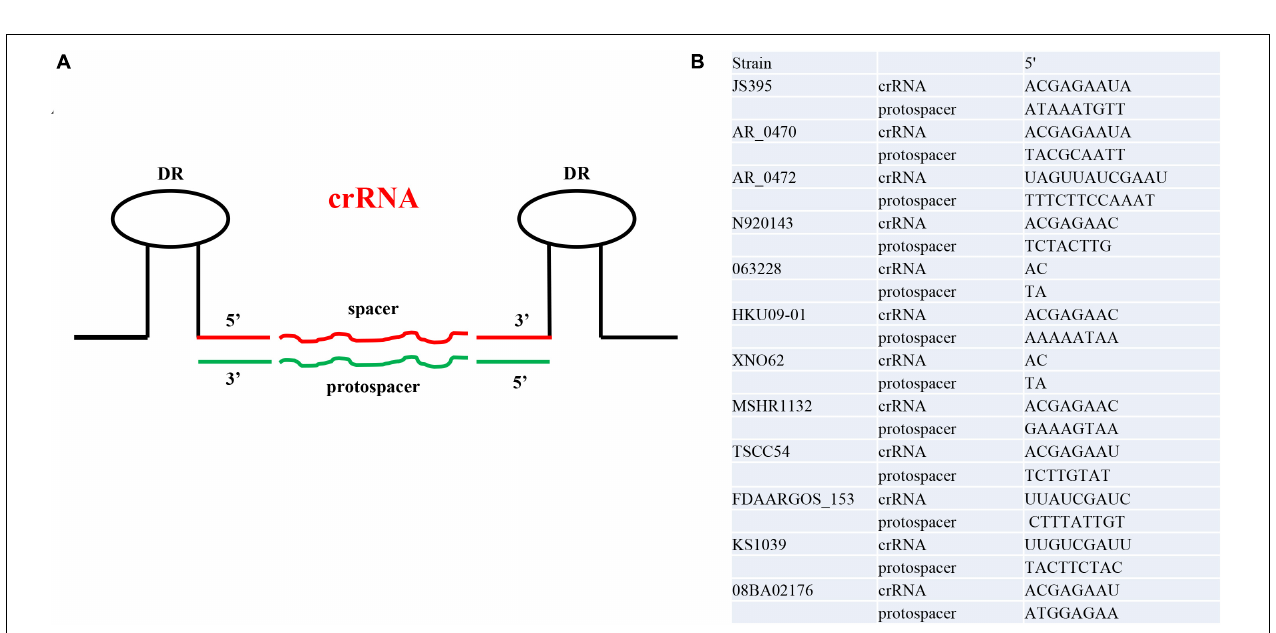
FIGURE 4 | The schematic diagram and examples of the crRNA 5’ handle and protospacer 3’ end. (A) The schematic diagram of crRNA and protospacer. (B) Complementarity of crRNA 5’ handle and protospacer 3’ end. One Staphylococci has a representative.